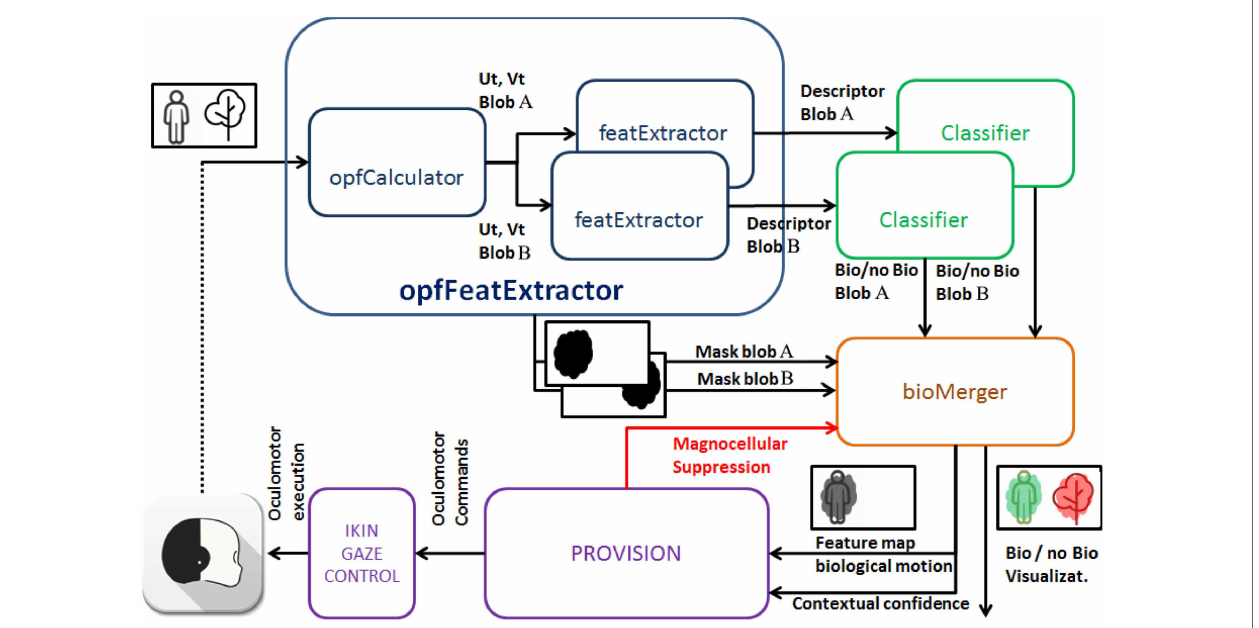
FIGURE 6 | The iCub architecture where our method has been implemented